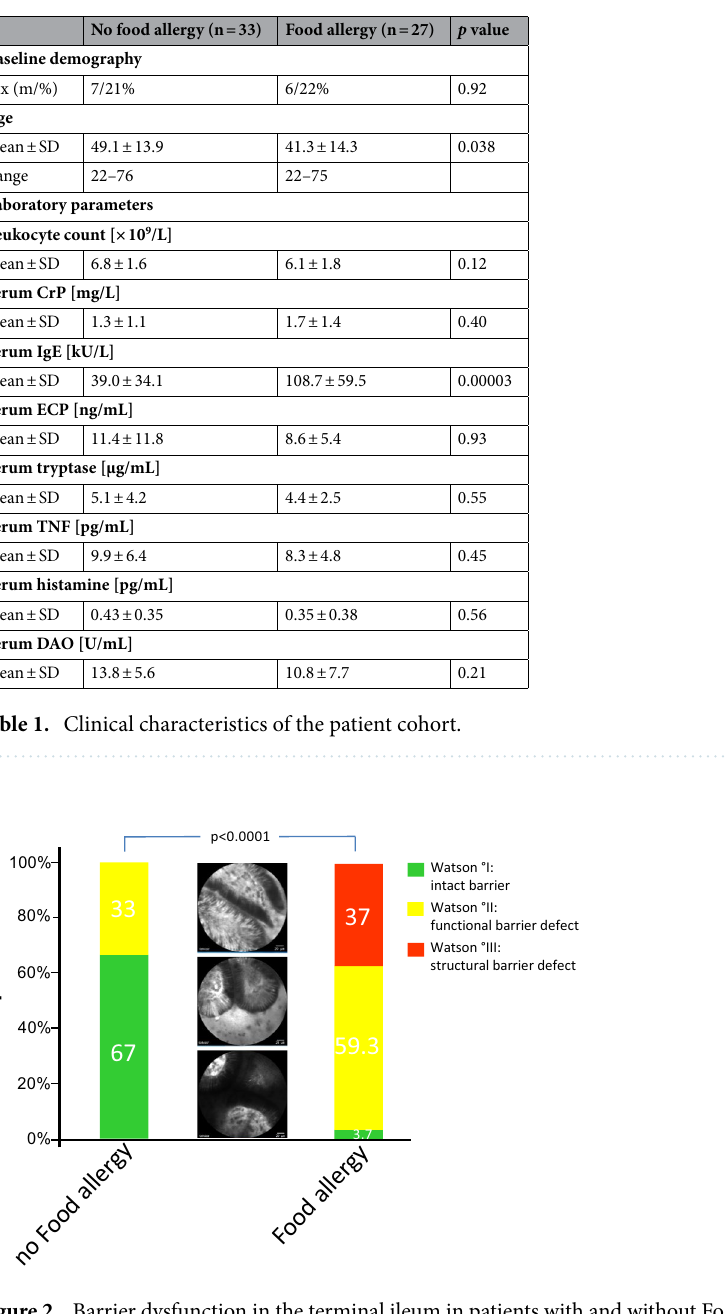
Figure 2. Barrier dysfunction in the terminal ileum in patients with and without Food Allergy. Overall, 26 out of 27 patients (= 96%) in the FA group exhibited barrier dysfunction in the terminal ileum under functional imaging with pCLE. In detail, 10 patients out of 27 patients (= 37%) exhibited a structural barrier dysfunction (Watson III) and 16 patients out of 27 patients (= 59.3%) had a functional barrier defect (Watson II). In the non-FA group, 11 out of 33 patients (= 33%) had barrier dysfunction, all of which were functional barrier defects. Differences in barrier dysfunction between patients with and without FA were statistically significant ( p < 0.0001). Middle panel: Representative images of the different grades of barrier dysfunction on pCLE; from bottom to top: Watson I, Watson II, Watson